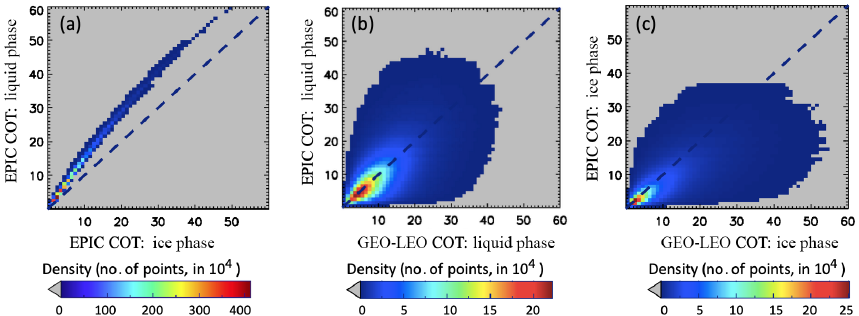
Figure 11. (a) Scatterplot for EPIC COT assuming liquid vs. ice phase; (b) EPIC COT vs. GEO–LEO composites: liquid clouds only as identified by the GEO–LEO algorithms; and (c) EPIC COT vs. GEO–LEO composites: ice clouds only as identified by the GEO–LEO algorithms. Data used are the same as in Fig.